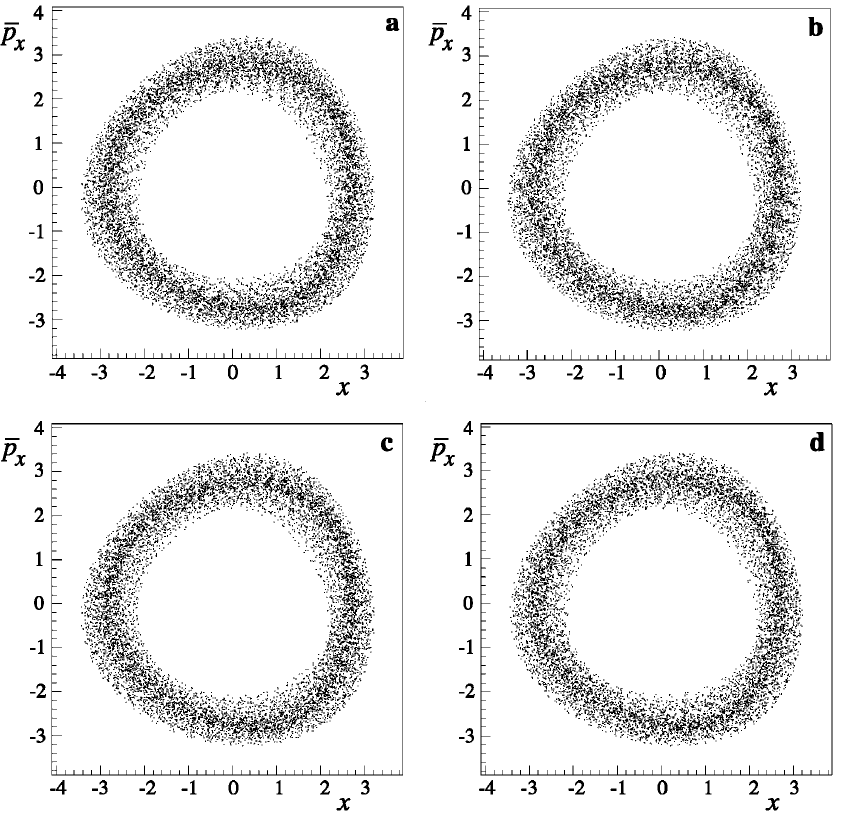
FIG. 2. Horizontal phase-space portraits generated at amplitude 10 (cid:31) for the LHC optics, version 6, seed 39. The portraits shown derive from direct tracking (a), and Cremona map tracking at orders 10 (b), 8 (c), and 6